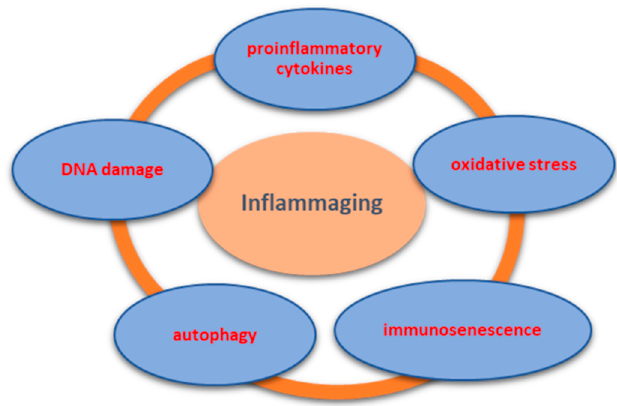
Figure 4. The main multifactorial mechanisms related to inflammaging. The aging process of the body is complex, influencing numerous cellular, immunological, and even genetic mechanisms. Thus, a proinflammatory status characterized by an excess secretion of proinflammatory cytokines such as interleukins (-1, -4, -6, -15), alpha tumor necrosis factor, or gamma interferon was revealed. Along with this inflammatory phenotype, an increase in the oxidative stress has been highlighted, which results in the accumulation of oxygen metabolites. Furthermore, in the aging process, there is a decrease in the autophagy capacity, which determines pronounced proinflammatory responses and mitochondrial damage. DNA damage response is directly related to telomere shortening and favors proinflammatory status through its action on stem cells, fibroblasts, or macrophages, thus exacerbating the phenomenon of inflammaging.